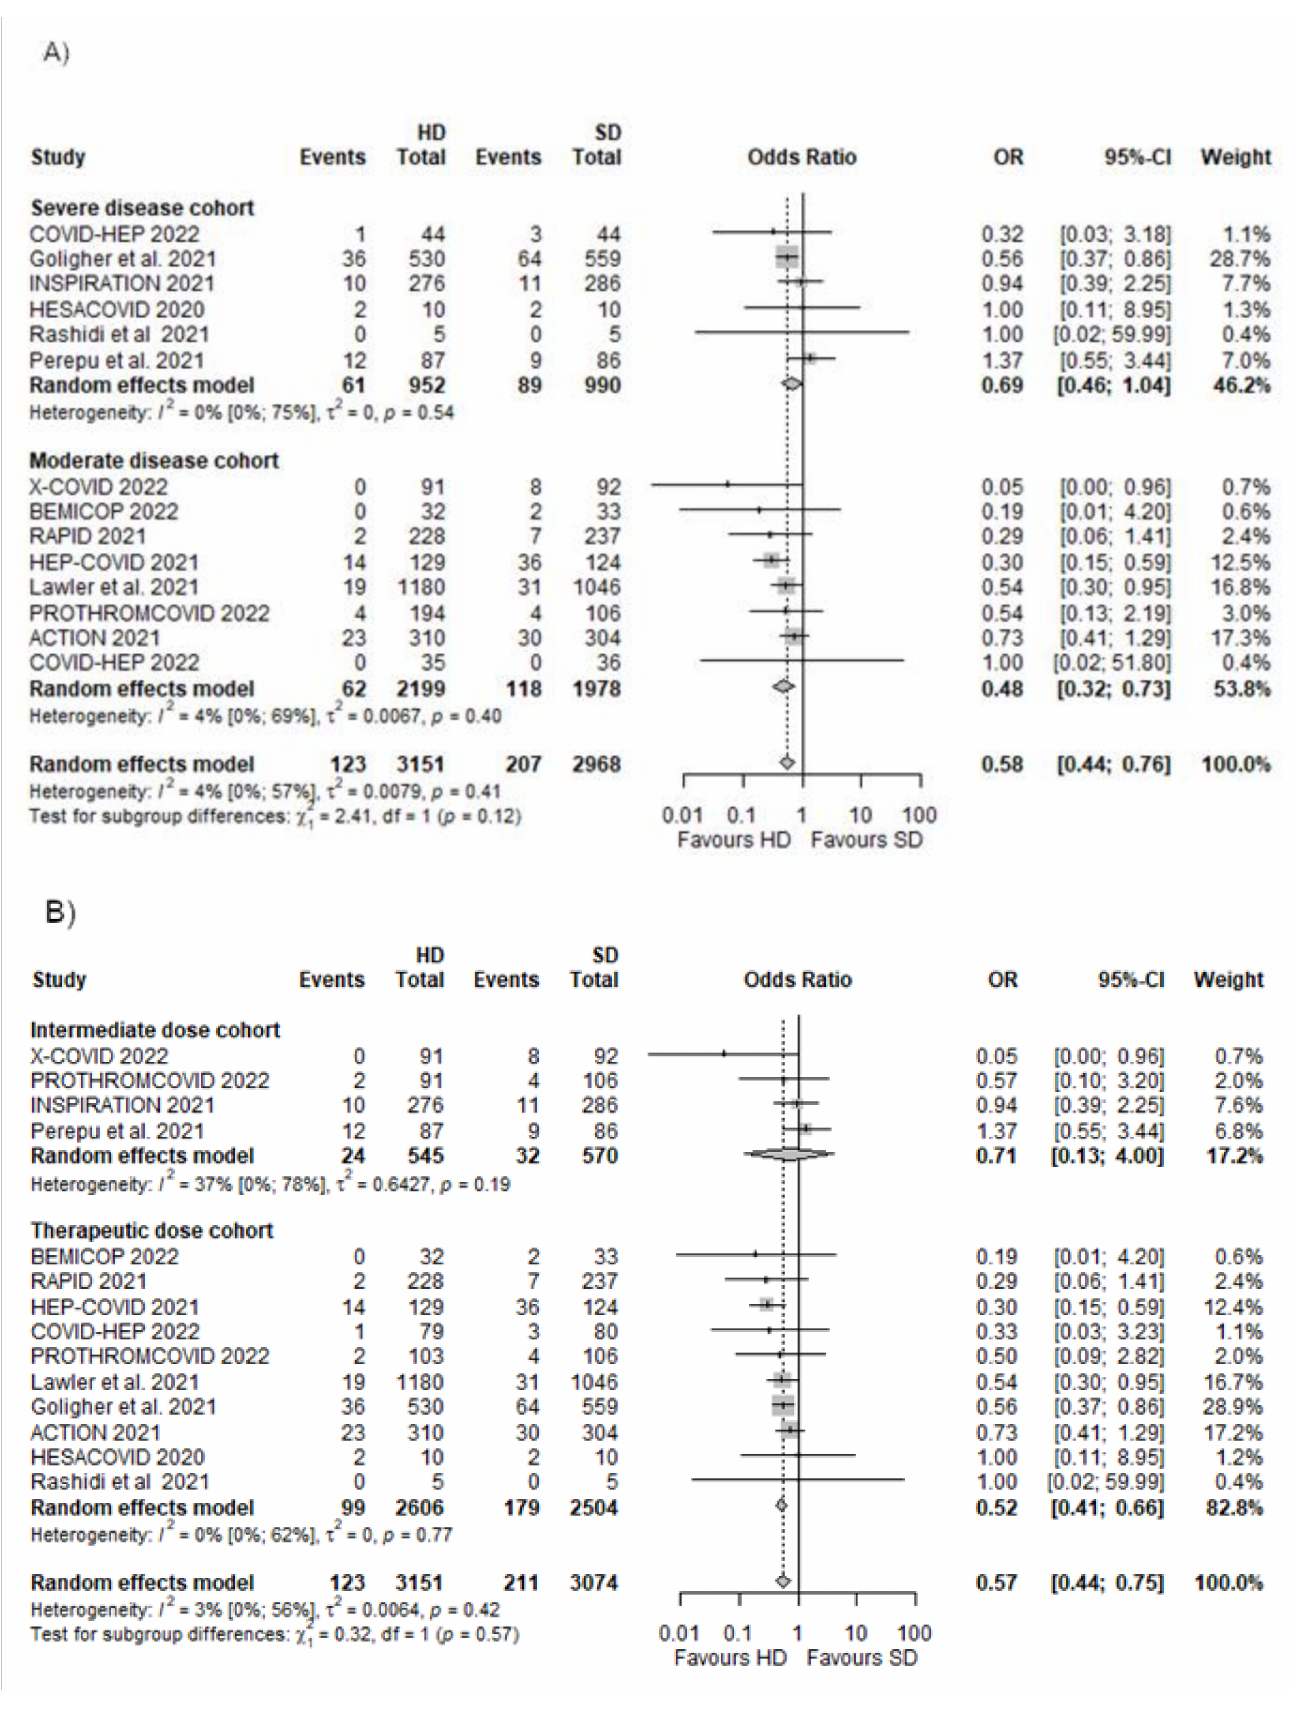
Figure 4. Any thrombotic events in different dosing regimens in moderate and severe disease cohorts [19–25,51–56]. ( A ) Any thrombotic events in severe and moderate disease cohorts; ( B ) any thrombotic events in cohorts where an intermediate or therapeutic dose was used in the HD